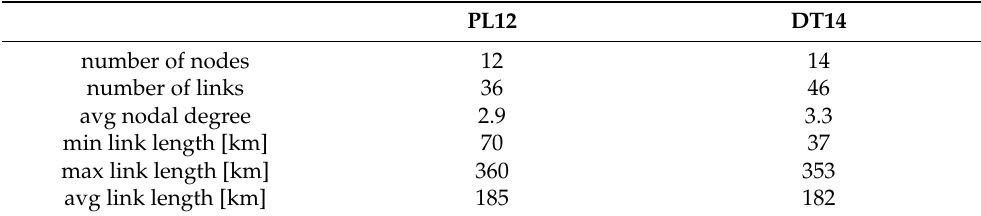
Table 3. Characteristics of the examined